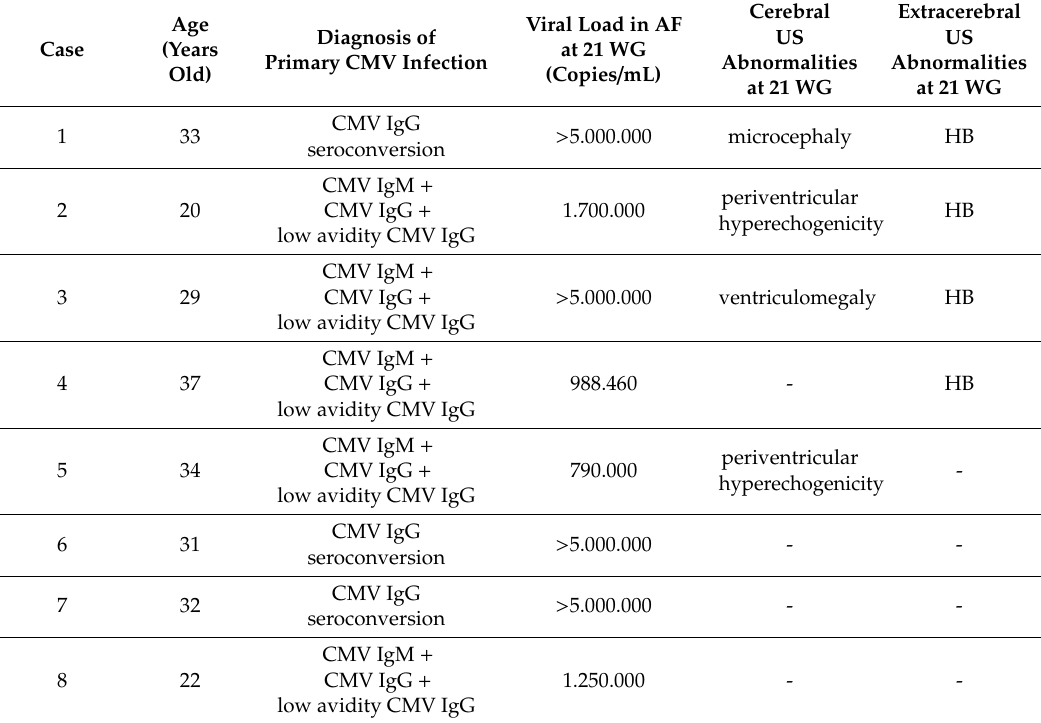
Table 1. Diagnosis of maternal and fetal CMV infection in the study